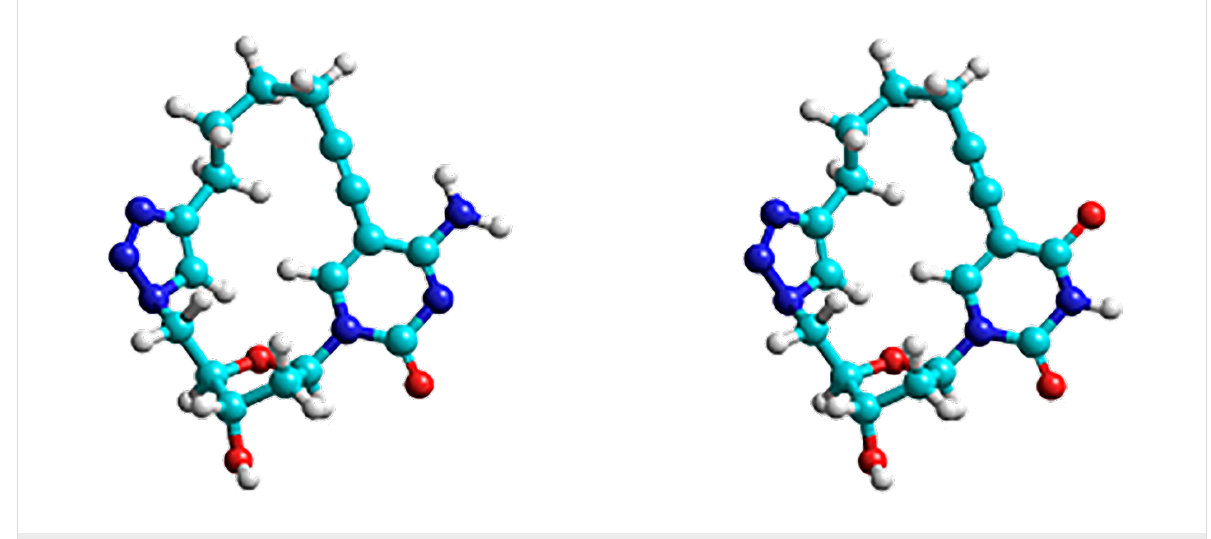
Figure 1: Energy-minimized models of the two macrocycles derived from dC (left) and dU (right) acquired by MM + simulation using Hyperchem 8.0.10; both showing the accessibility of the Watson–Crick recognition